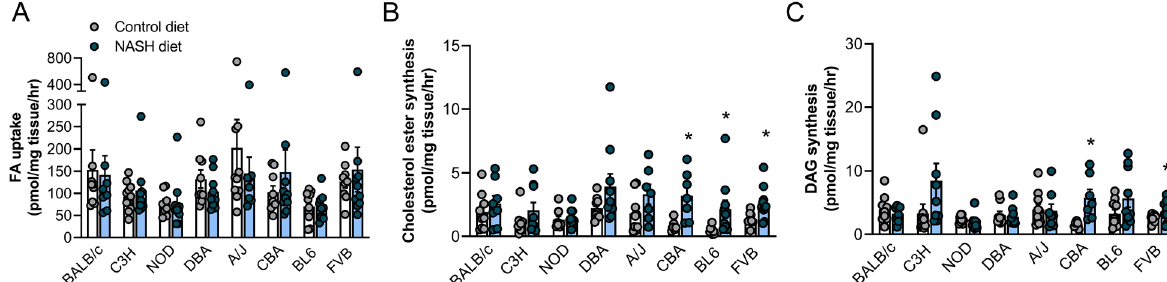
Figure 3. Assessment of hepatic lipid metabolism. Lipid metabolism was assessed in precision-cut liver slices using [ 14 C]-radiolabelled fatty acids. ( A ) Fatty acid uptake (n = 8–11/group), ( B ) cholesterol ester synthesis (n = 6–11/group) and ( C ) diacylglycerol (DAG) synthesis (n = 6–10/group), with mouse strains in all graphs sorted by increasing prevalence of NASH and liver fibrosis (as assessed by histopathological grading). Data are means ± SEM, *p < 0.05 vs. respective controls, as assessed by two-way unpaired